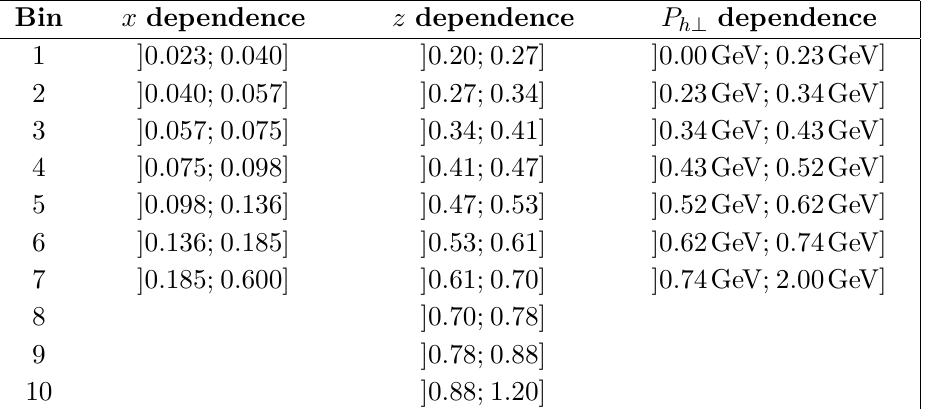
Table 8 . Definition of the one-dimensional binning for (anti)protons: the first column lists the bin number; the second, third, and fourth columns give the corresponding limits in the kinematic variables x , z , and P h ⊥ ,